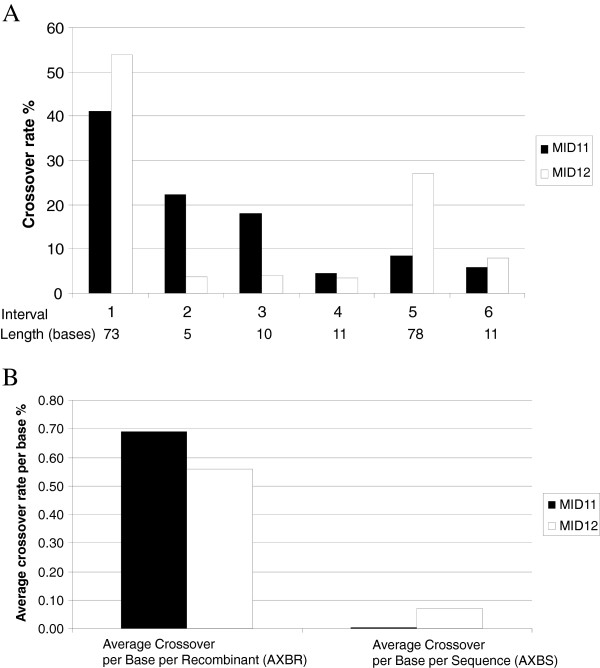
Recombinant crossover rate estimation. (A) Observed crossover rates at each interval of recombinant sequences in Run3. The Y axis is the crossover rate in percentage. The X axis shows the interval sites between each drug resistance site and the length of the intervals. (B) Normalized average crossover rates. AXBR was obtained by dividing average crossover/base by total number of recombinant sequences. AXBS was obtained by dividing average crossover/base by the total number of all sequences.